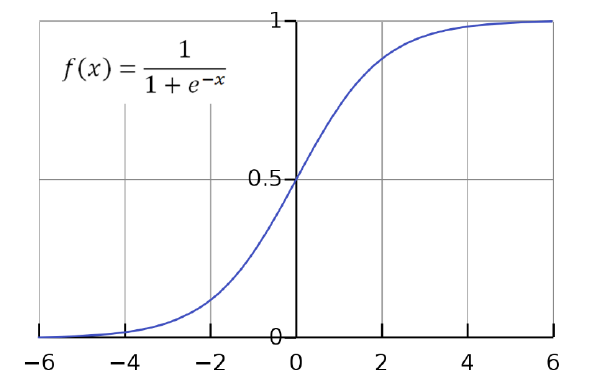
Figure 11. Sigmoid activation.